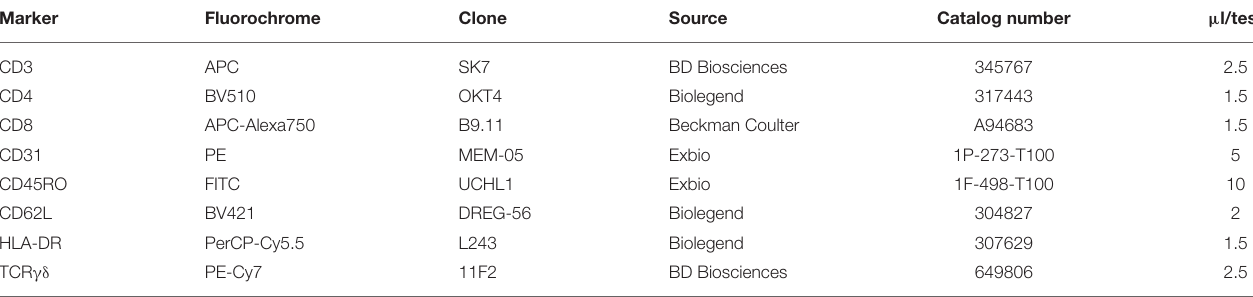
TABLE 2 | Composition of the EuroFlow SCID-RTE tube*.